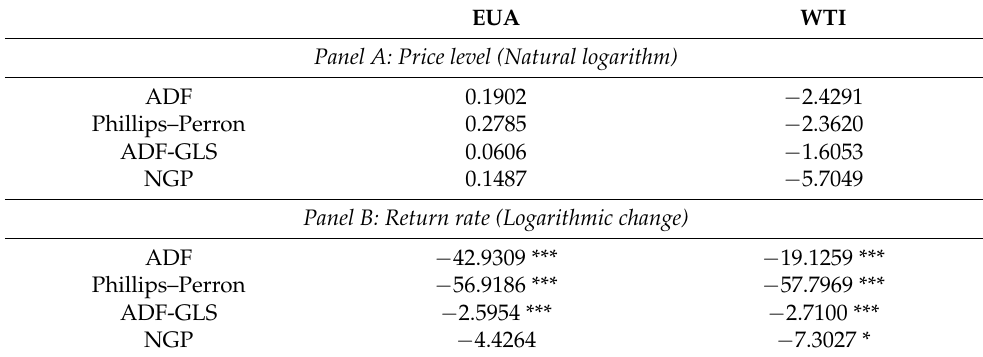
Table 2. Unit root